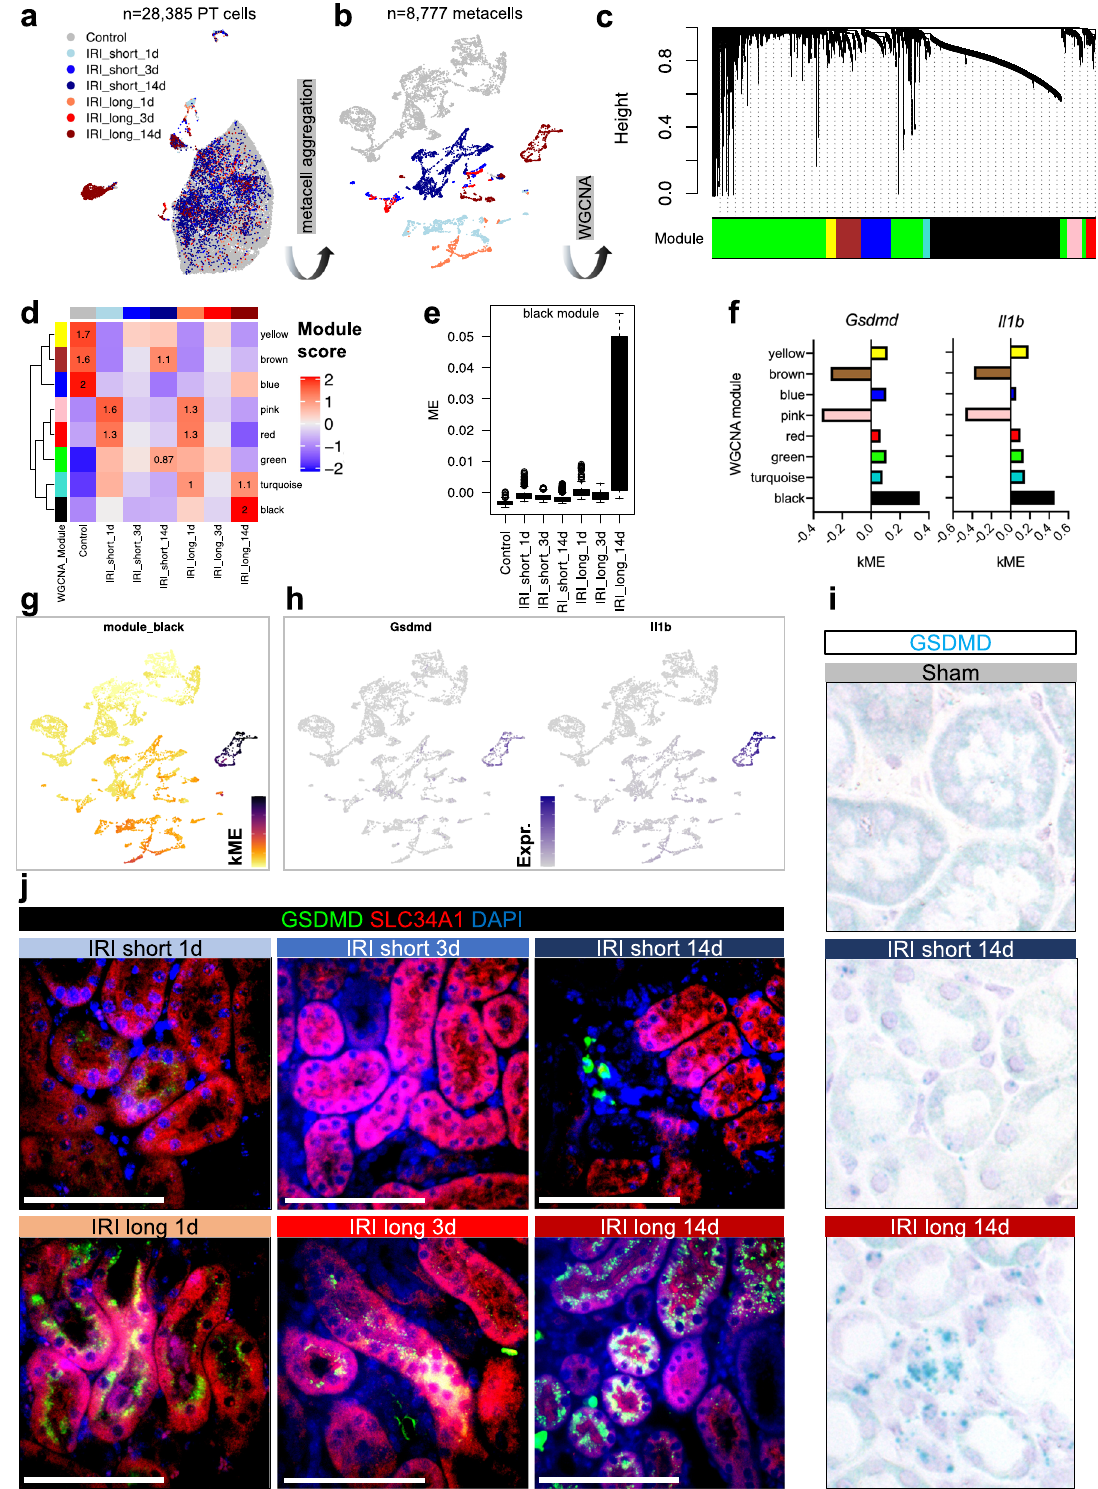
Fig. 6 WGCNA, in situ hybridization, and immuno fl uorescence con fi rm GSDMD as maladaptative repair-speci fi c hub gene expressed in PT. a UMAP visualizing PT cells colored by IRI degree and time post-ischemia. b UMAP visualizing PT metacells colored as in ( a ). c Hierarchical cluster tree showing gene co-expression modules identi fi ed by weighted correlation network analysis (WGCNA) in PT cells revealed 8 modules (color-coded). d Heatmap demonstrating high WGCNA module speci fi city among treatment groups strati fi ed by IRI degree and time post-ischemia. e Module eigengene (ME) scores of black WGCNA module in n = 8777 metacells by IRI degree and time post-ischemia, displayed as Tukey box plots (outliers denoted as dots outside box plot whiskers). f Intramodular connectivity (kME) values for individual hub genes Gsdmd and Il1b show high speci fi city for black module. g , h kME values ( g ) and Gsdmd and Il1b expression ( h ) visualized in UMAP space. i In situ hybridization showing presence of Gsdmd mRNA in IRI long 14 d kidney tubules. j Immuno fl uorescence staining representative of n = 3 independent experiments of GSDMD (green) and PT marker SCL34A1 (red); scale bars = 50 µ m. NATURE COMMUNICATIONS| (2022) 13:4018 |https://doi.org/10.1038/s41467-022-31772-9|www.nature.com/naturecommunications